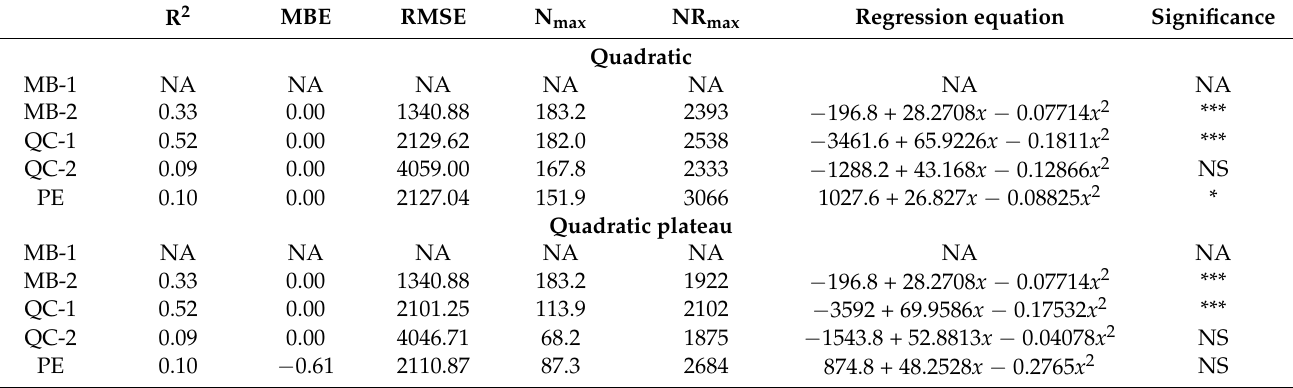
Table 9. Maximum nitrogen rate (N max ) to obtain maximum NR (NR max ) by fitting the data with five models ( n = 60). R 2 MBE RMSE Regression